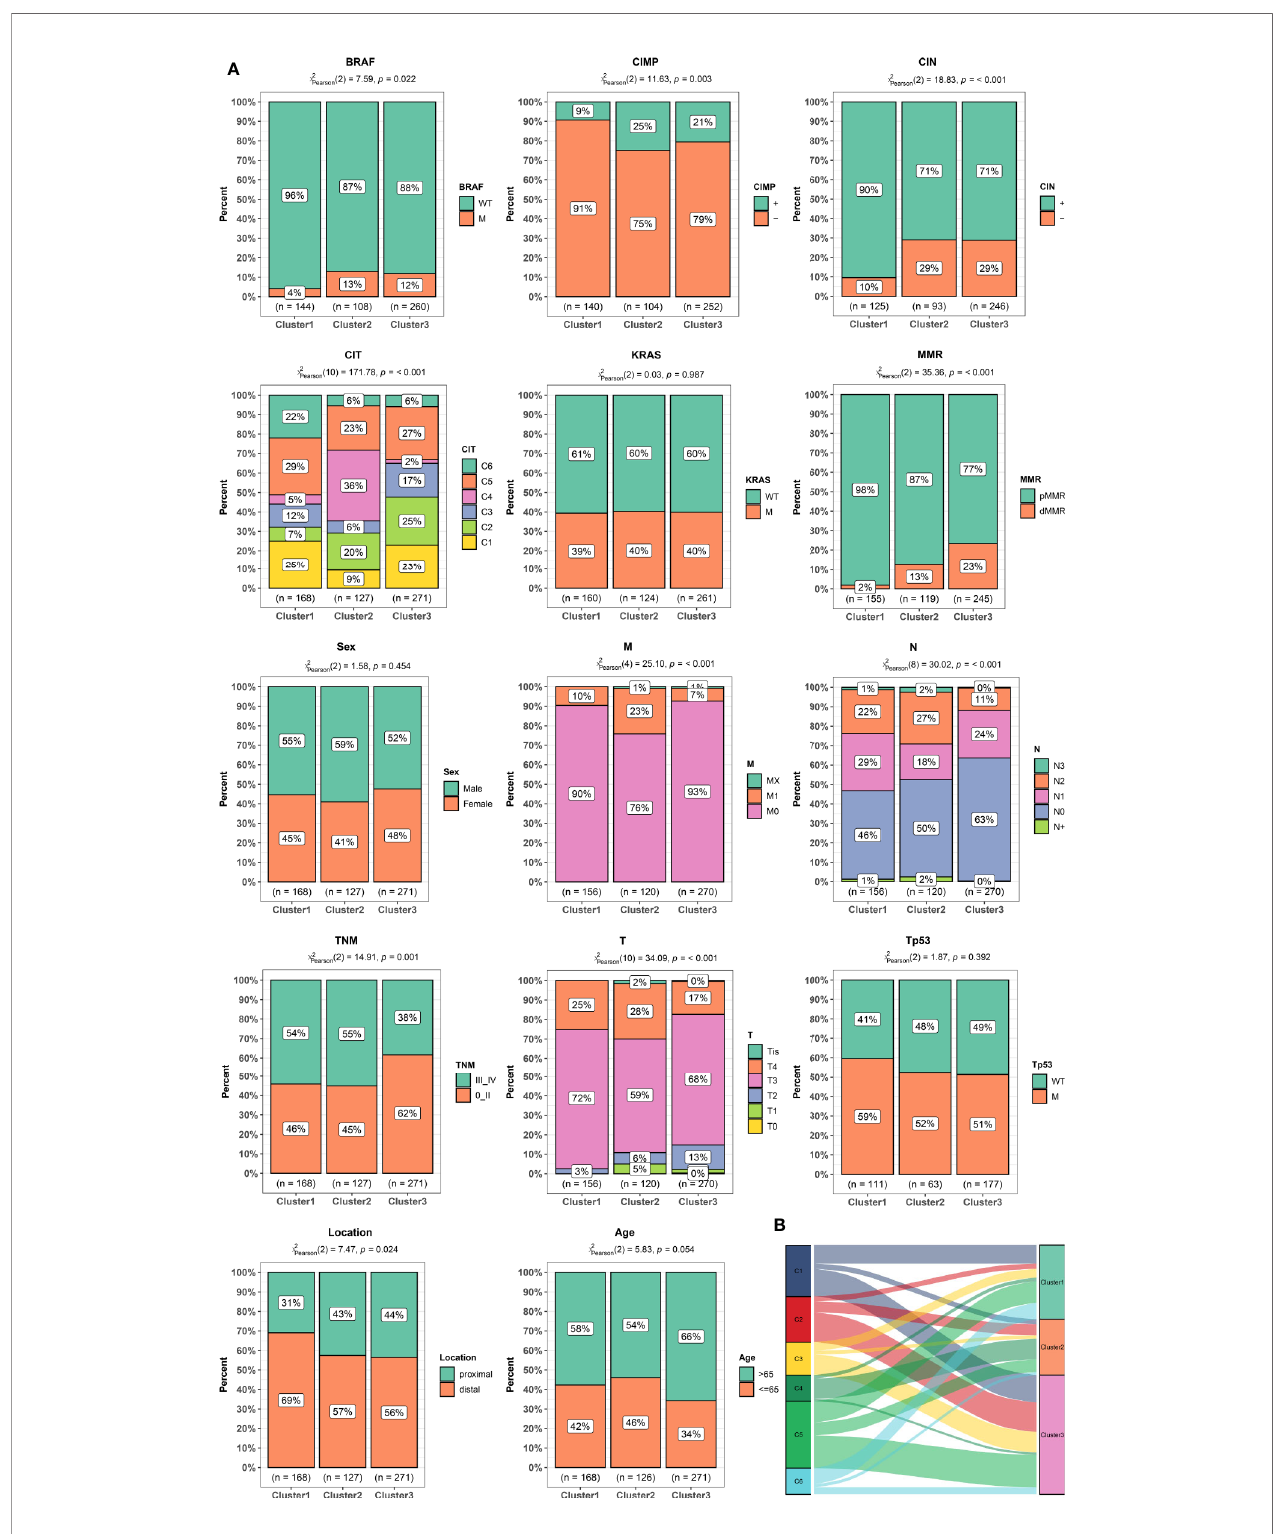
FIGURE 2 | Clinical and molecular characteristics of colorectal cancer (CRC) patients according to the cluster. (A) Bar plots showing the proportion of gender, age, stage, tumor localization, KRAS, BRAF, and TP53 mutations, hypermutated phenotype, mismatch repair status (MMR), CpG island methylator phenotype (CIMP), chromosomal instability (CIN), and Cartes d ’ Identite´ des Tumeurs (CIT) subtypes in different clusters. (B) Sankey chart displaying the distribution of C1 – C6 CIT subtypes in different